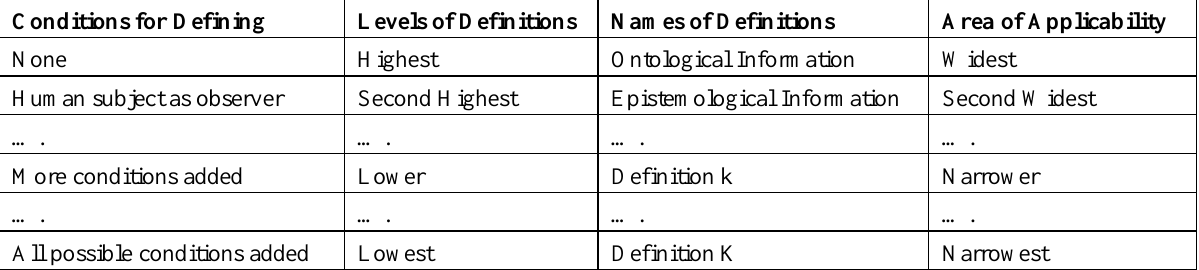
Table 2. System Approach to Information Defining and the Related